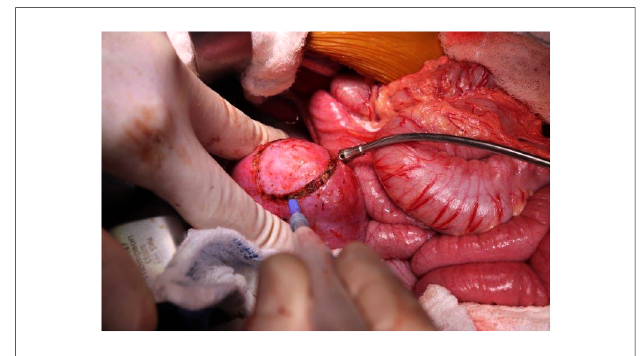
FIGURE 2 Scoring the renal capsule around the location of the tumor to highlight the anticipated course of dissection.